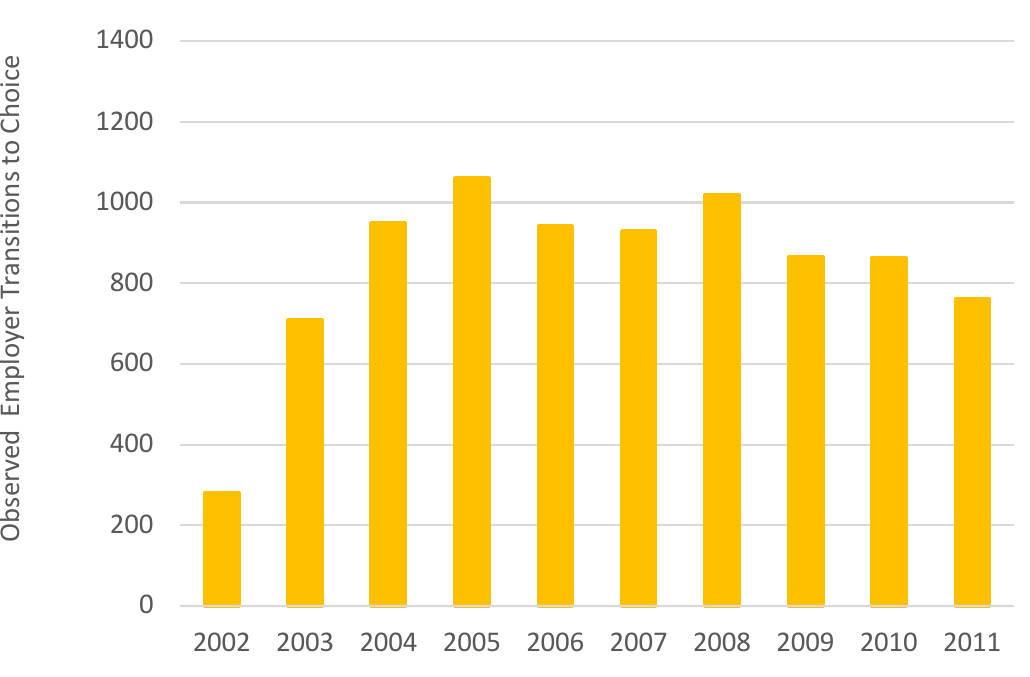
Figure 2: Annual incidence of employer transitions to devolved plan choice in analytic sample, 2002 to 2011. Notes: Data source: commercial claims data